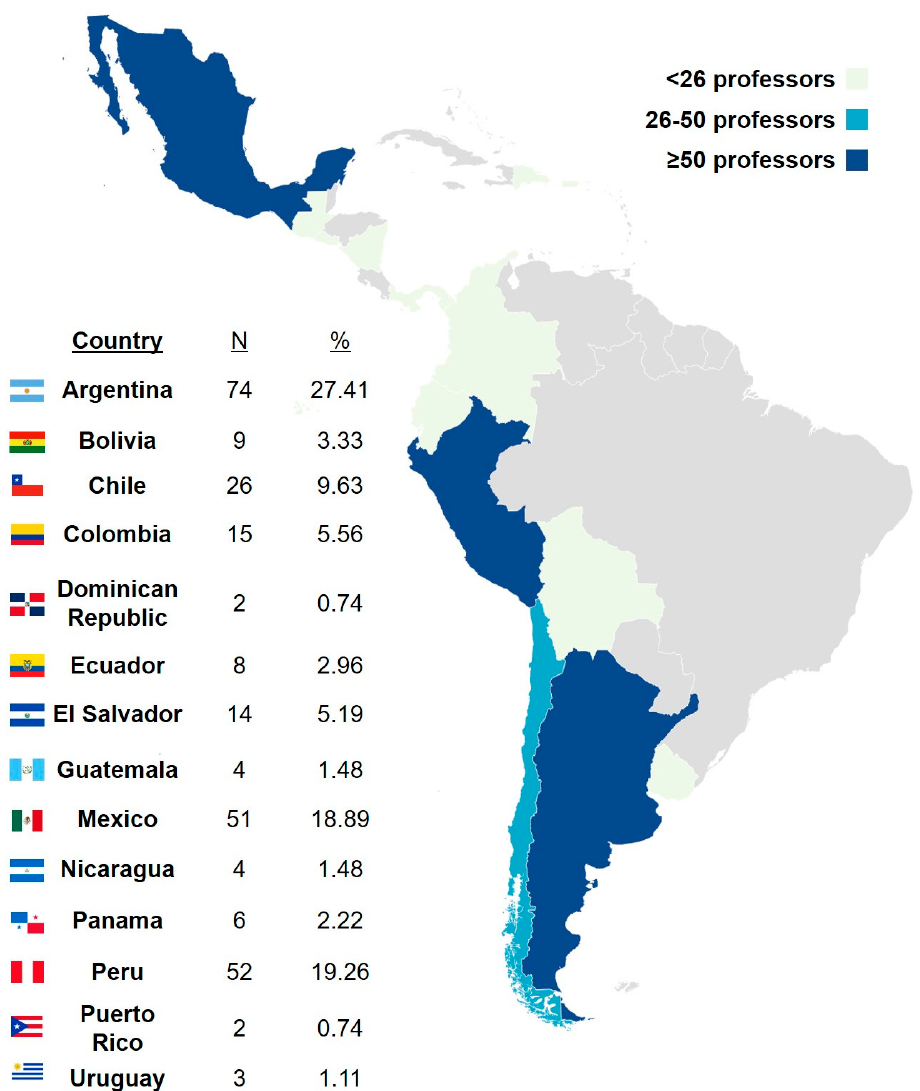
Figure 3. Distribution of the participants by their country of origin. Among the participants, 52.22% teach at private universities and 47.78% at public universities, which represents a homogeneous distribution by university tenure (chi- square = 0.5333, df = 1, p -value = 0.4652). In both types of universities, the sample is made up of mostly females (Figure 4). Although this majority is larger in the case of private universities, the gender bias in the sample is similar in both private and public universities (chi-square = 3.2663, df = 1, p -value = 0.0707). The mean age in private universities (46.60 years, with a standard deviation of 10.41) is almost 8 years lower than that of the partici- pants in public universities (54.19 years, with a standard deviation of 9.48). Also, the left skewness of the ages of private university participants ( − 0.28, Figure 4a) is slightly higher than that of the public university professors ( − 0.26, Figure 4b).